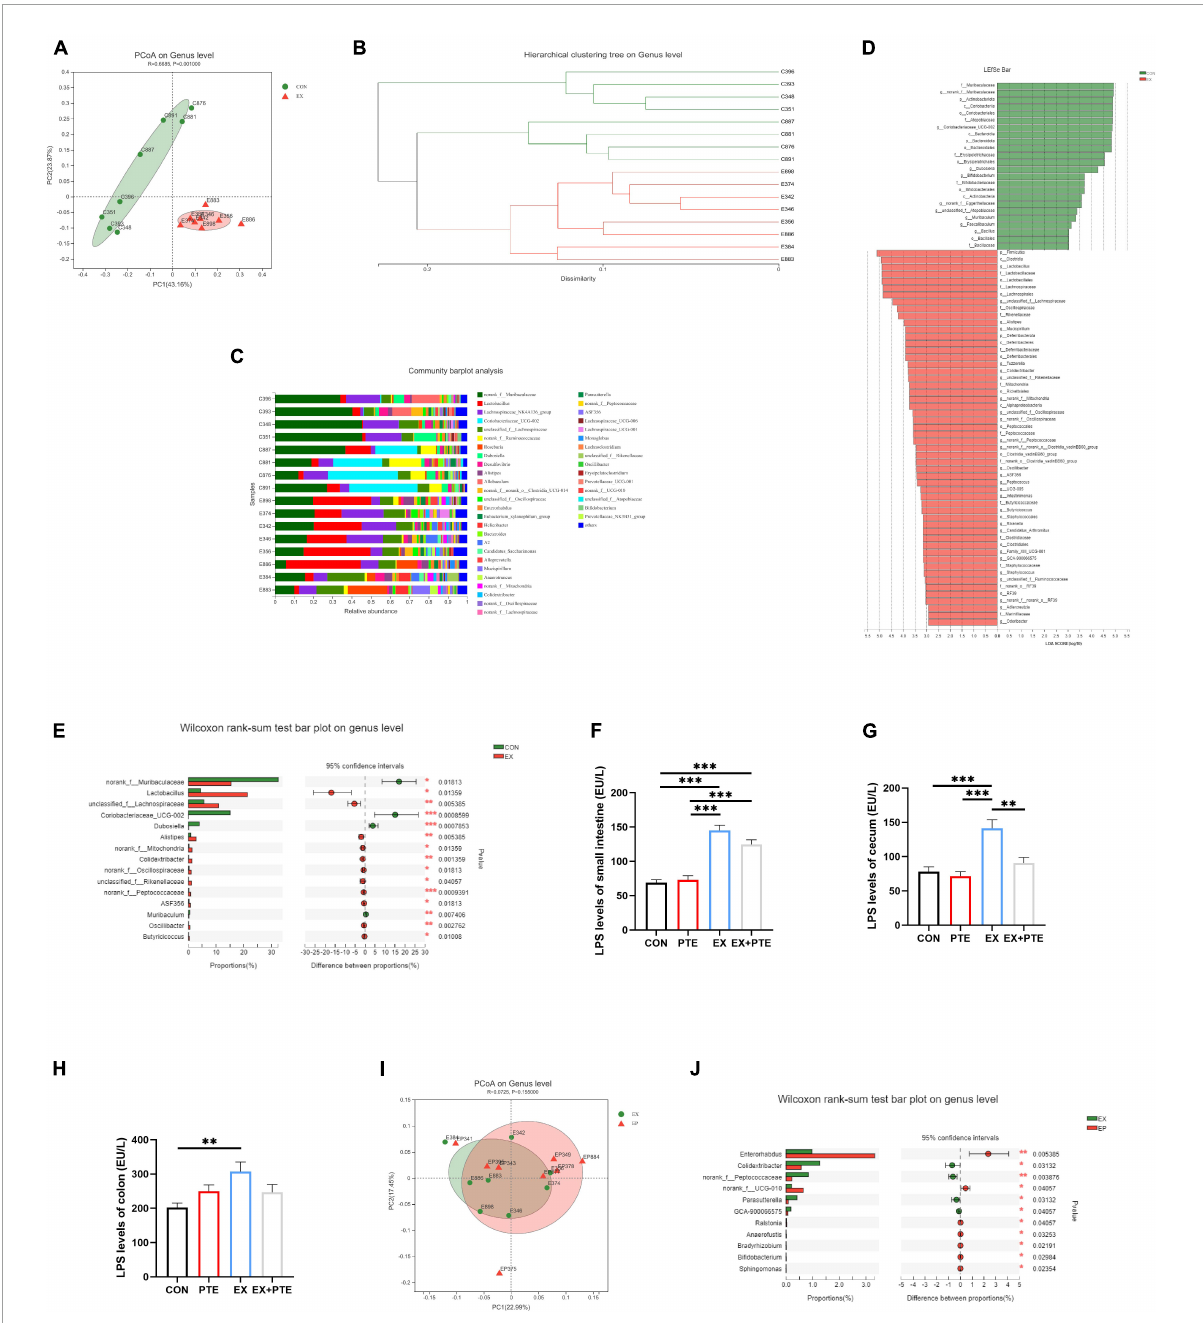
FIGURE3 Exercise treatment modified the gut microbiota and induced LPS production. (A) Principal coordinate analysis (PCoA) of the β -diversity based on the unweighted UniFrac distance matrix (at the ASV level) of the CON and EX groups. (B) Hierarchical cluster analysis. (C) The species composition of 16 samples at the genus level, based on the average distance. (D) Bar graph of linear discriminant analysis (LDA) scores, showing the biomarker taxa (LDA score of > 2 and a significance of p < 0.05 determined by the Wilcoxon signed-rank test). (E) The Kruskal–Wallis H test bar plot at the genus level of CON and EX groups. (F–H) LPS was detected by ELISA kits of intestinal contents ( F : PTE: F = 1.769, p = 0.194; EX: F = 104.762, p < 0.001; interaction: F = 3.724, p = 0.064; G : χ 2 = 14.966, p < 0.05; H : PTE: F = 0.091, p = 0.765; EX: F = 5.766, p < 0.05; interaction: F = 6.364, p < 0.05). (I) PCoA of EX and EX + PTE group. (J) Kruskal–Wallis H test bar plot at the genus level of EX and EX + PTE groups. Data were expressed as means ± SEM, and the statistical significance was showed using asterisks denote ( ∗∗ p < 0.01; ∗∗∗ p <